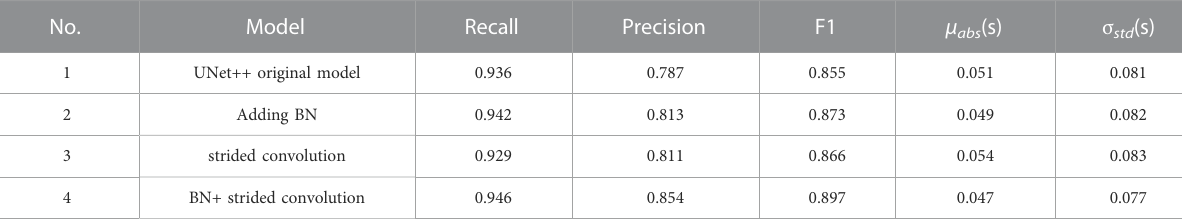
TABLE 1 Performance comparison after different improvements.